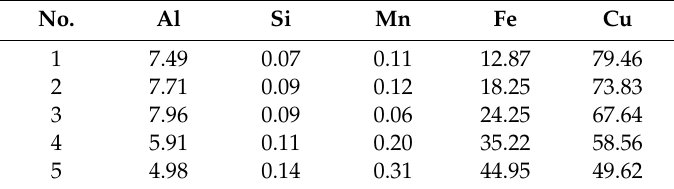
Table 2. Average compositions of the obtained composite coating (according to XRMA), weight %.